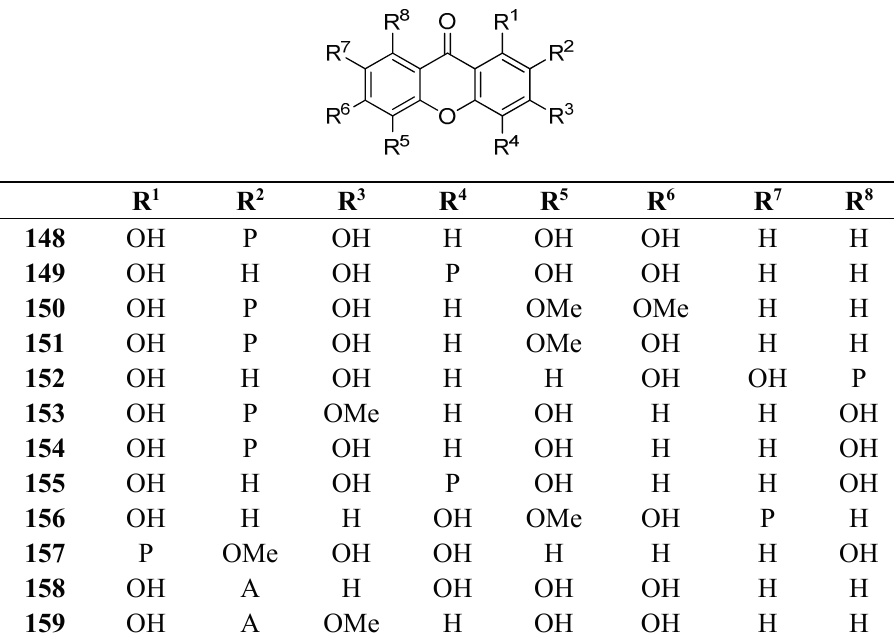
Figure 6. Chemical structures of tested hexaoxygenated